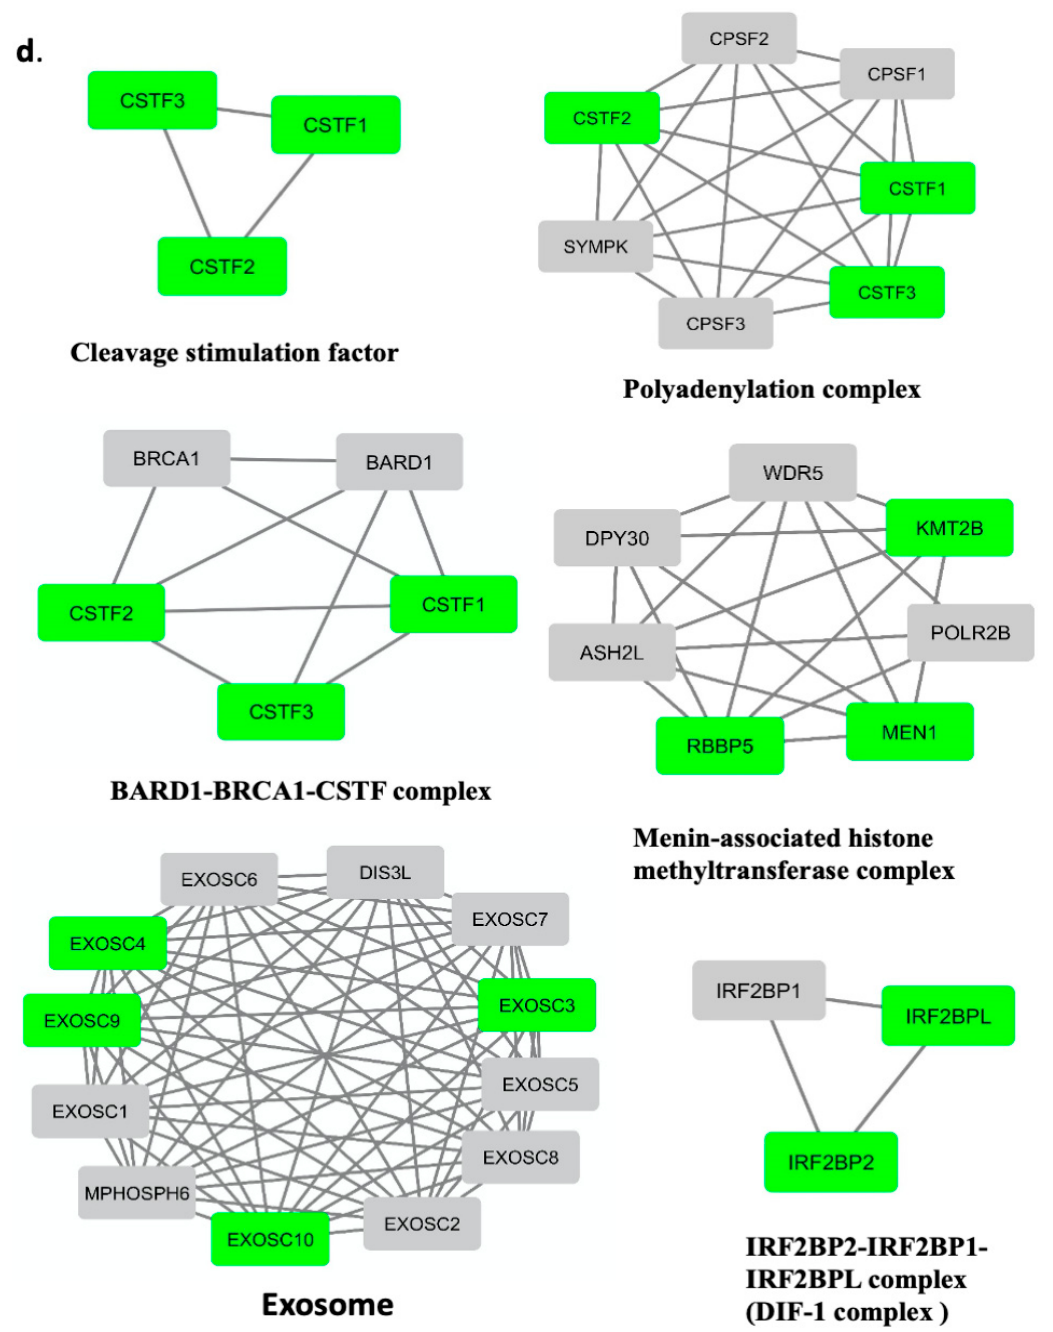
Figure 6. Identification of Menin’s interactome in Hs 578T cells using IP coupled LC/MS/MS. ( a ) The PPI network of identified menin’s interactome was constructed by stringdb websever. ( b , c ) Functional enrichment analysis of menin’s interactome using g:Profiler (https://biit.cs.ut.ee/gprofiler/gost, accessed on 30 December 2020); ( b ) top ten GO-BP terms enriched racking by p -value; ( c ) enriched protein complexes found in the CORUM database. ( d ) Modeling of protein complexes found in the menin’s interactome. Green nodes: proteins found in identified menin’s interactome in TNBC. Grey nodes: the ones not found in the interactome.